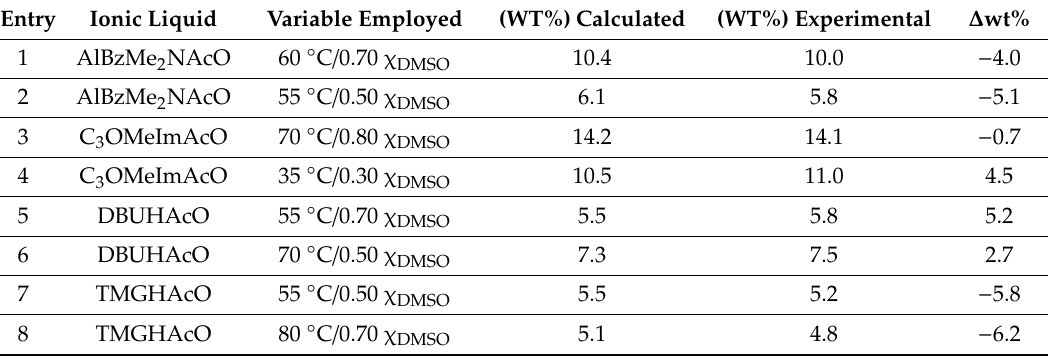
Table 3. Comparison of predicted and experimental cellulose dissolution data a